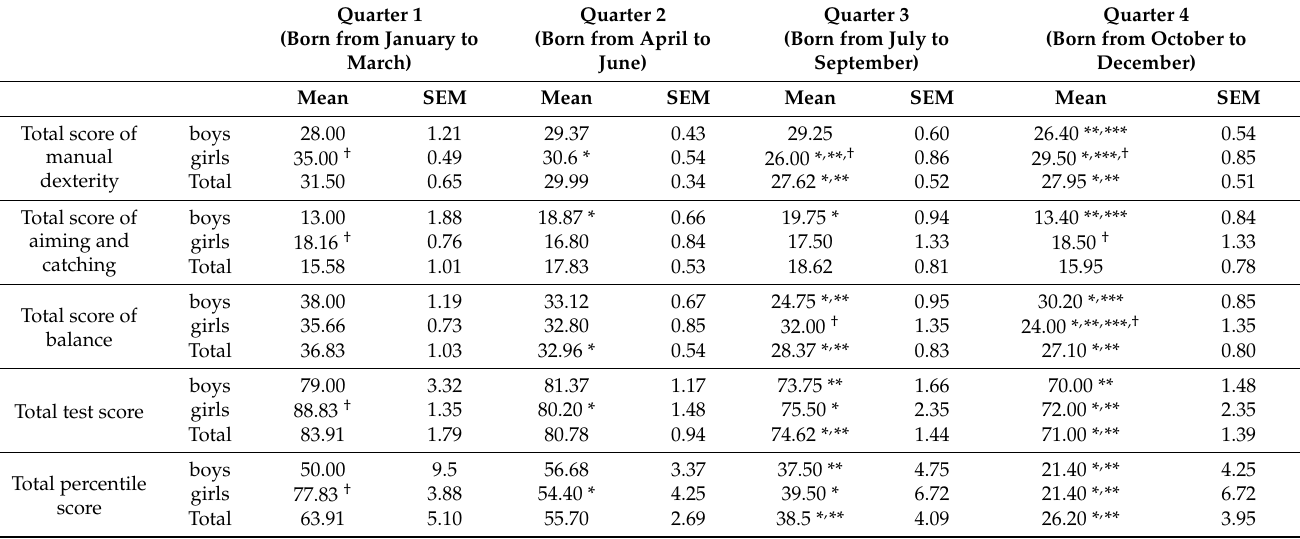
Table 1. Results of Movement Assessment Battery for Children-2 (MABC-2) test based on sex and the quarter of birth.